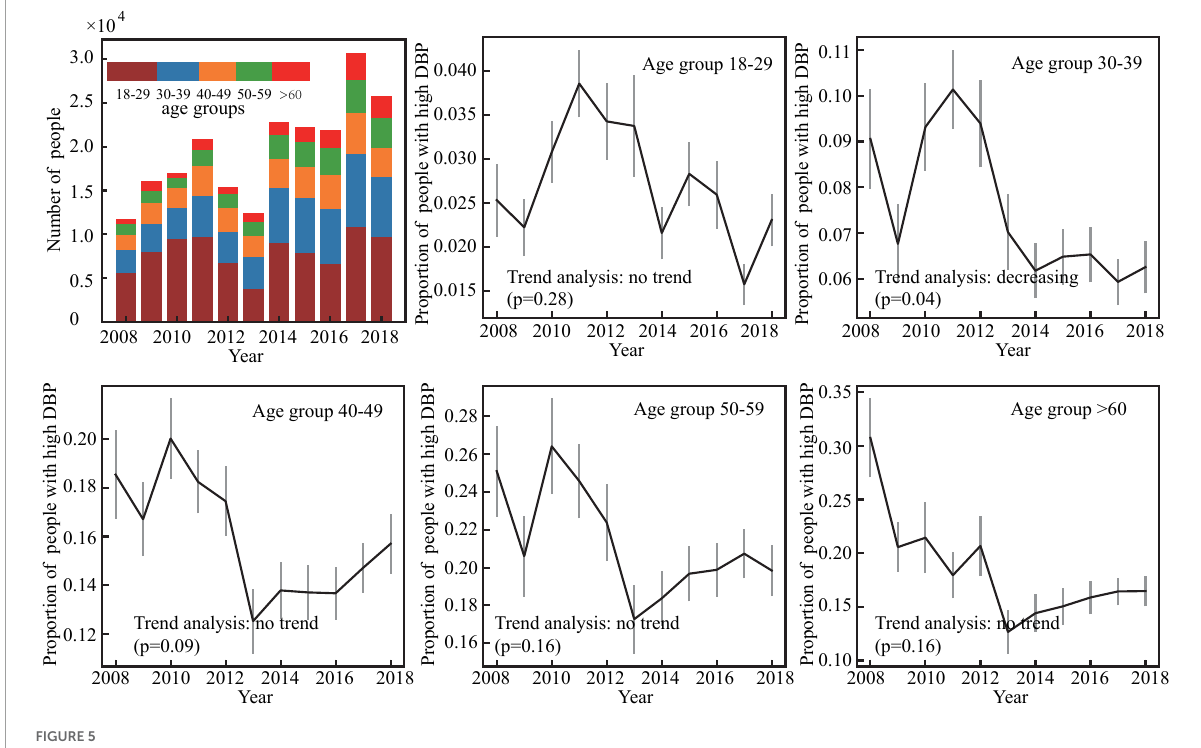
FIGURE5 Varience of the number of high DBP male participants with time in Guangdong, China ( N = 44010).